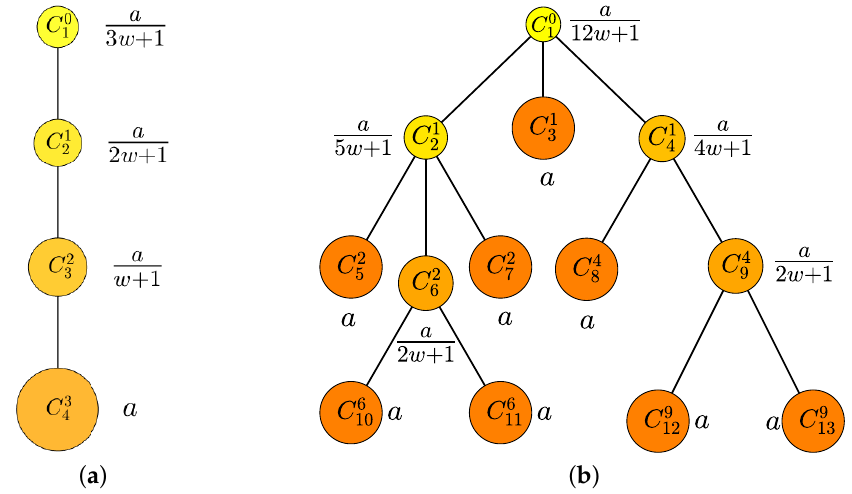
Figure 5. Example of P3: ( a ) Fully ordered set (simple) with I C = { 1,2,3,4 } and ( b ) Partially ordered set (complex) with I C = { 1,2, · · · ,13 } . The size and color of the node mean the size of the reward. The larger the size and darker the color of the node, the larger the reward to be paid. The rewards for each node that make the sum of the rewards of each chain ( a , b ) become U C are expressed using a and w .